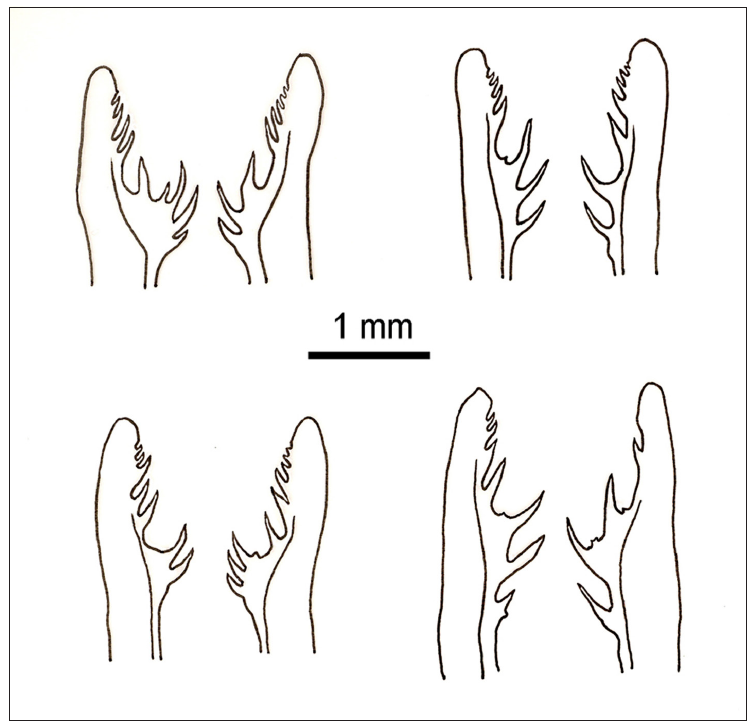
Fig. 9. Inter- and intra-individual variations of the extremities of valvae in a population of E. zolvizora chachapoya ssp. nov. from San José de Molinopampa, Amazonas, Peru